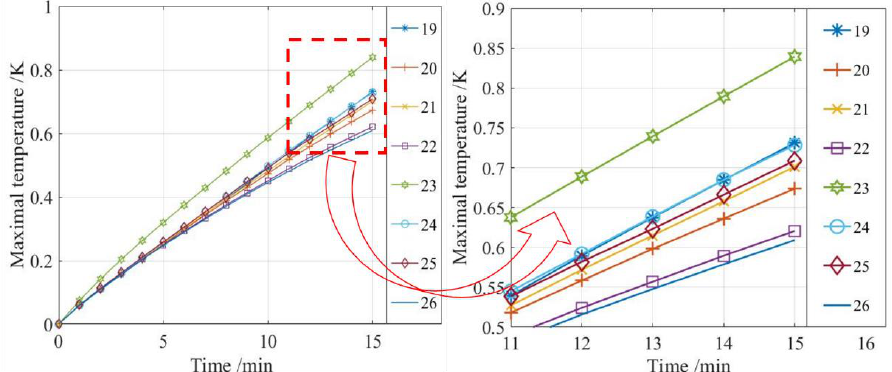
Figure 19. TSD of schemes for the battery pack with a single inlet and single outlet over time.